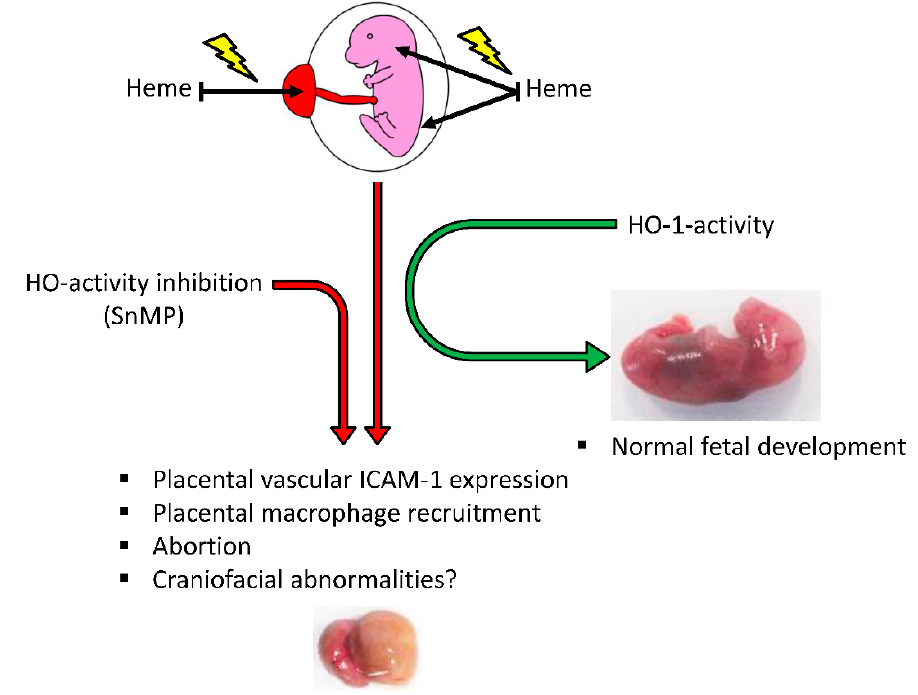
Figure 5. Hypothetical model: Heme oxygenase protects against placental vascular inflammation and abortion by the alarmin heme in mice. This study demonstrated that heme acted as an endogenous “alarmin” during pregnancy in a dose-dependent fashion, while HO-activity protected against heme-induced placental vascular inflammation and abortion. We postulate that heme-induced inflammatory response promoted endothelial cell activation, which upregulated the expression of ICAM-1, facilitating the recruitment of macrophages into placental tissue, resulting in a pathological pregnancy, increasing the risk of abortion and possibly craniofacial abnormalities. Inhibition of HO-activity will increase the heme-induced inflammatory response, albeit HO-activity will attenuate heme-induced inflammation, promoting normal fetal development.